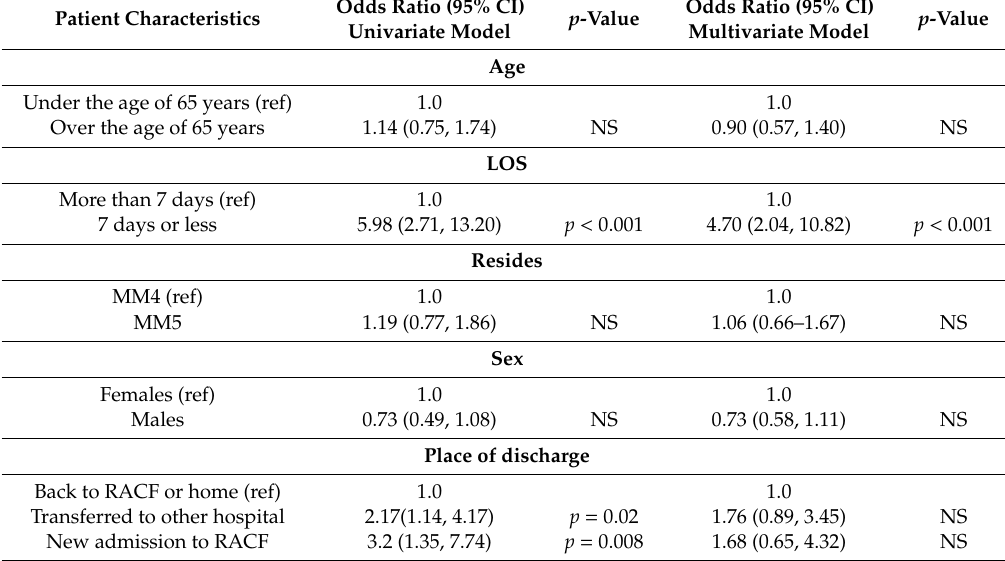
Table 5. Demographic factors and the association with a high nutrition risk score (univariate and multivariate